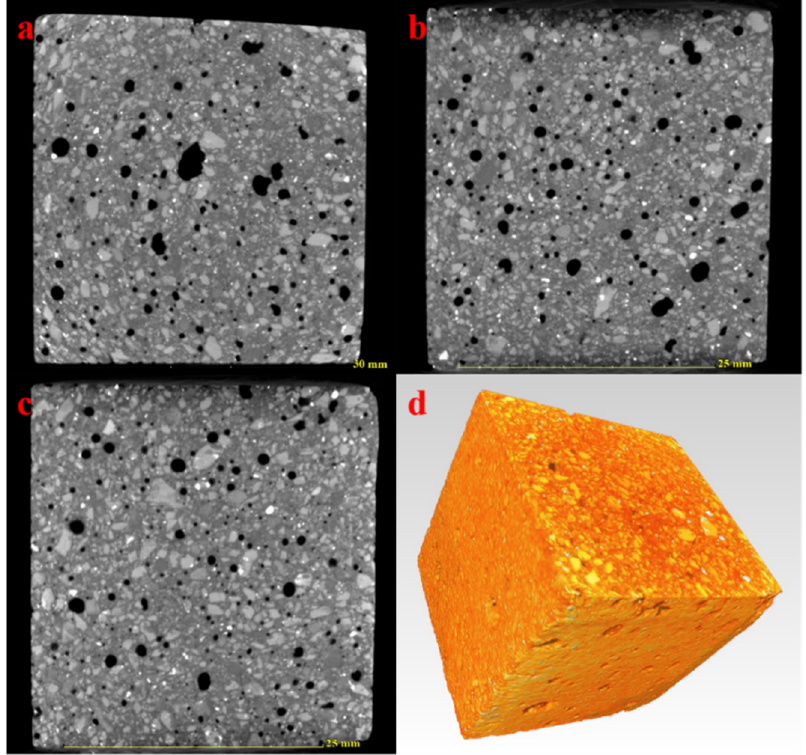
Figure 10. XY, XZ, YZ directional slices ( a – c ) and 3D scanning image of AACM specimen ( d ). Digital core analysis and threshold segmentation are used for quantitative analysis of the different components of the material in order to understand the pore structure of AACM at a greater distance. The principles and applications of digital core analysis and